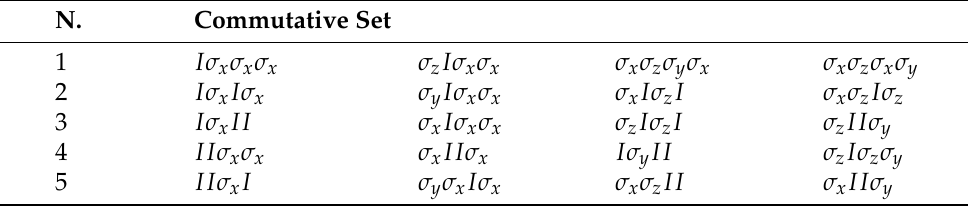
Table 3. Commutative sets (generators) whose eigenstates form a WUS of degree 5. N.